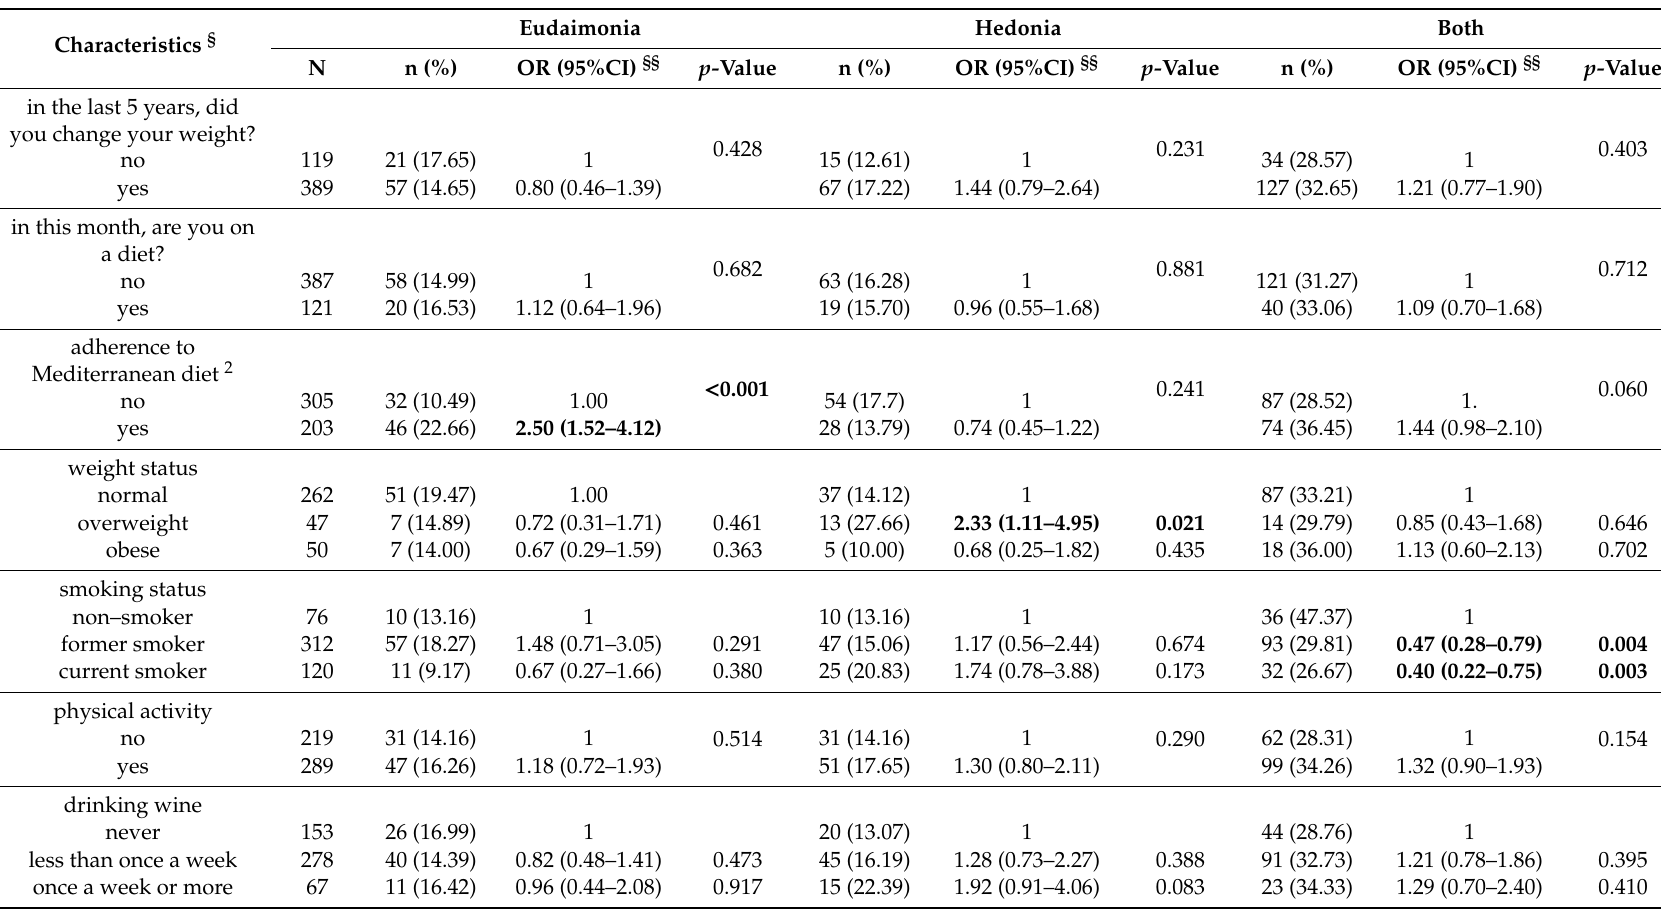
Table 2. Psychological well-being by behavioral characteristics in a sample of 508 undergraduates of University of Palermo: univariable